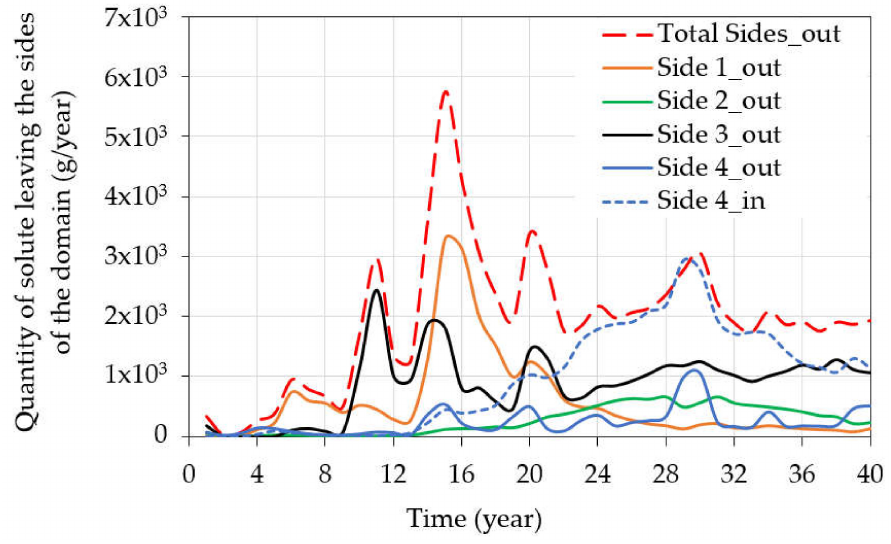
Figure 12. The amount of atrazine entering and leaving the aquifer through four lateral sides (Side 4_in represents atrazine volumes entering through Side 4, Side 1_out to Side 4_out represent atrazine leaving through corresponding lateral sides, and Total Sides_out represents the amount of solute leaving though all lateral